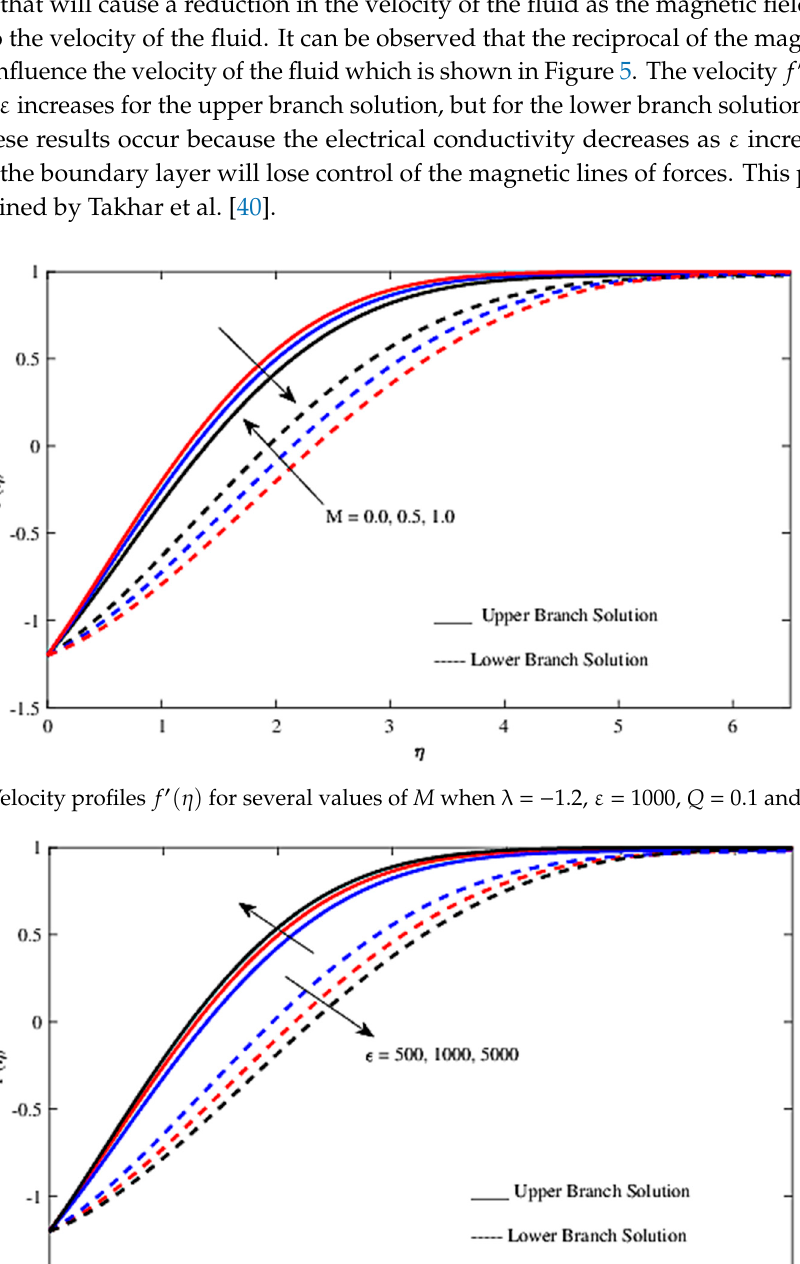
Figure 3. Variation of the Nusselt number (0)  with λ for different values of M with ε = 1000, Q = 0.1 and Pr = 1.0.